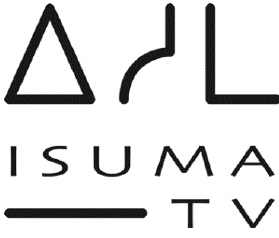
Figure 3. Isuma TV, a project of Isuma Distribution International Inc. Source: www.isuma.tv/isuma, accessed on 11 September 2021. accessed on 11 September